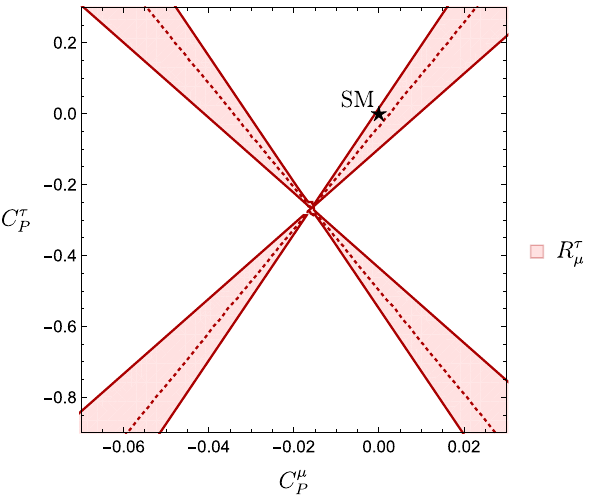
Fig. 1 Allowed regions in the C tonic ratio R τ μ